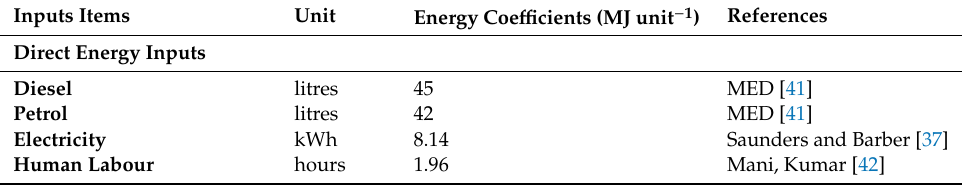
Table 1. Energy equivalents for inputs used in pastoral (PDFs) and barn (BDFs) dairy